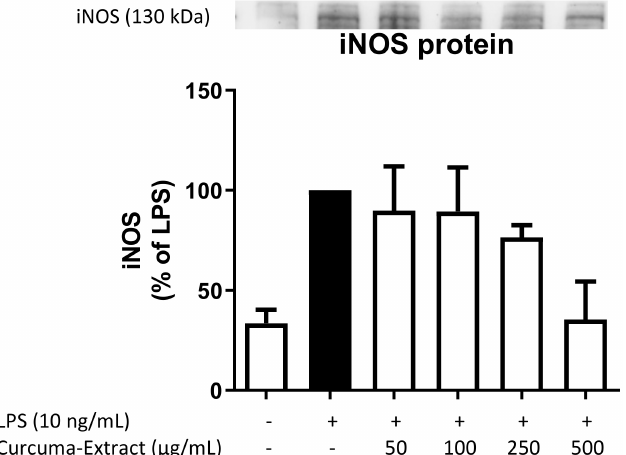
Figure 3. Effects of TE on iNOS protein levels in LPS-stimulated BV2 cells. TE was added 30 min before stimulation with 10 ng/mL LPS. After 24 h, Western Blot analysis was performed. Values are presented as the mean ± SEM of three independent experiments, and statistical analysis was performed using one-way ANOVA with Bonferroni post hoc test compared to LPS.